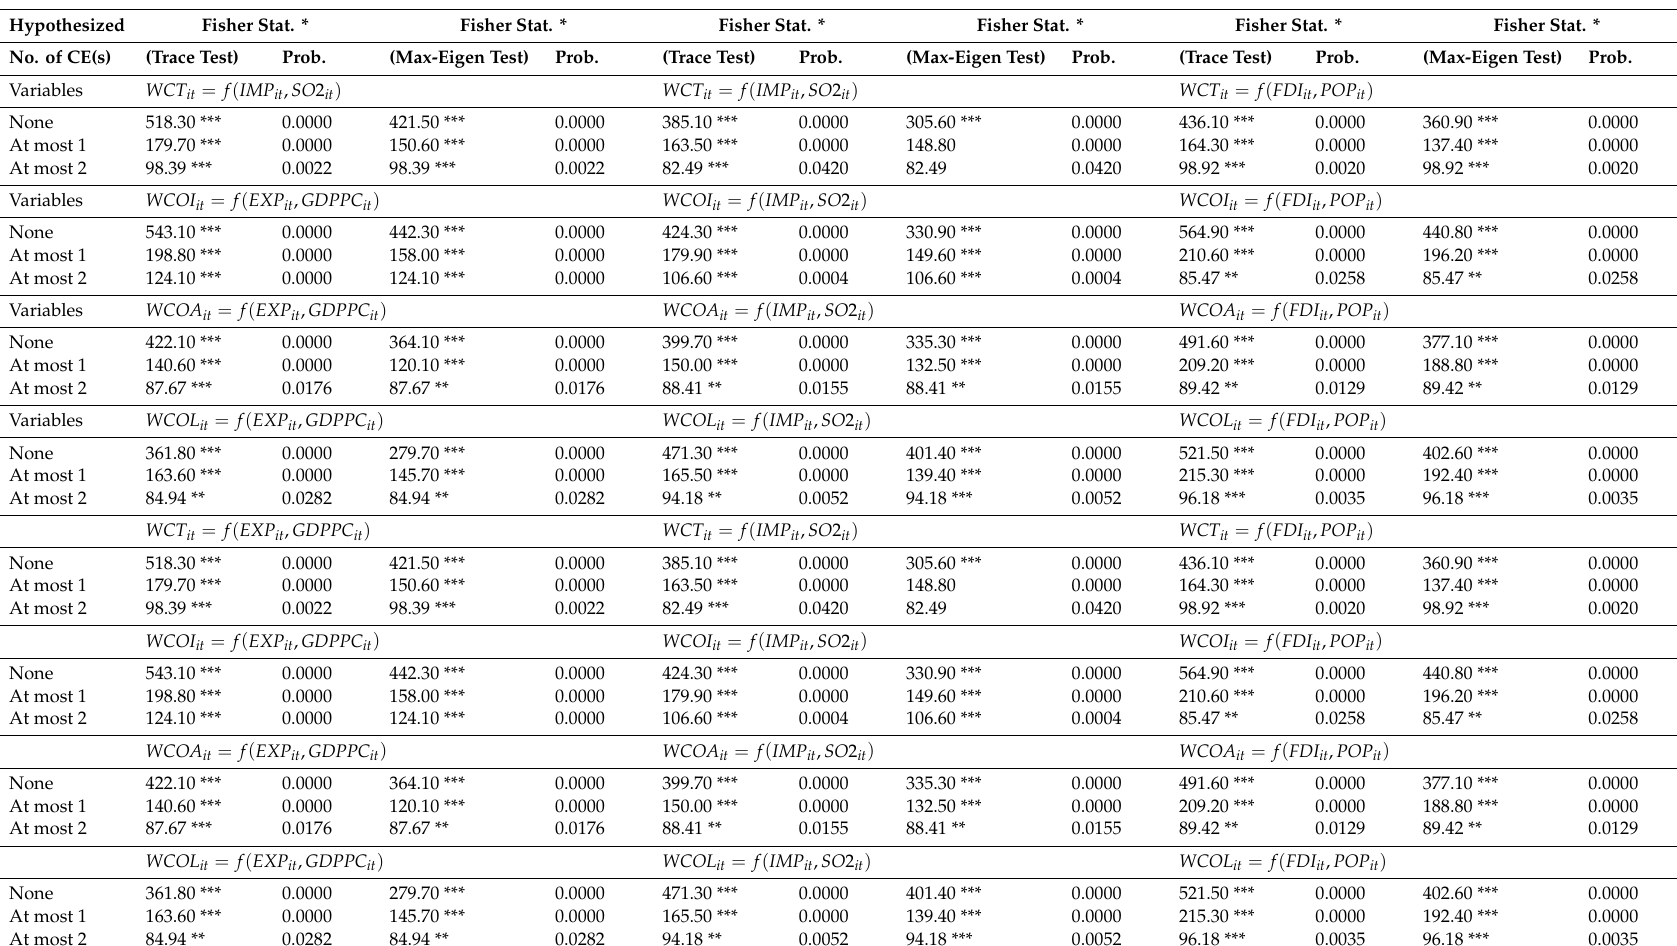
Table 6. Fisher-type Johansen cointegration test—whole of